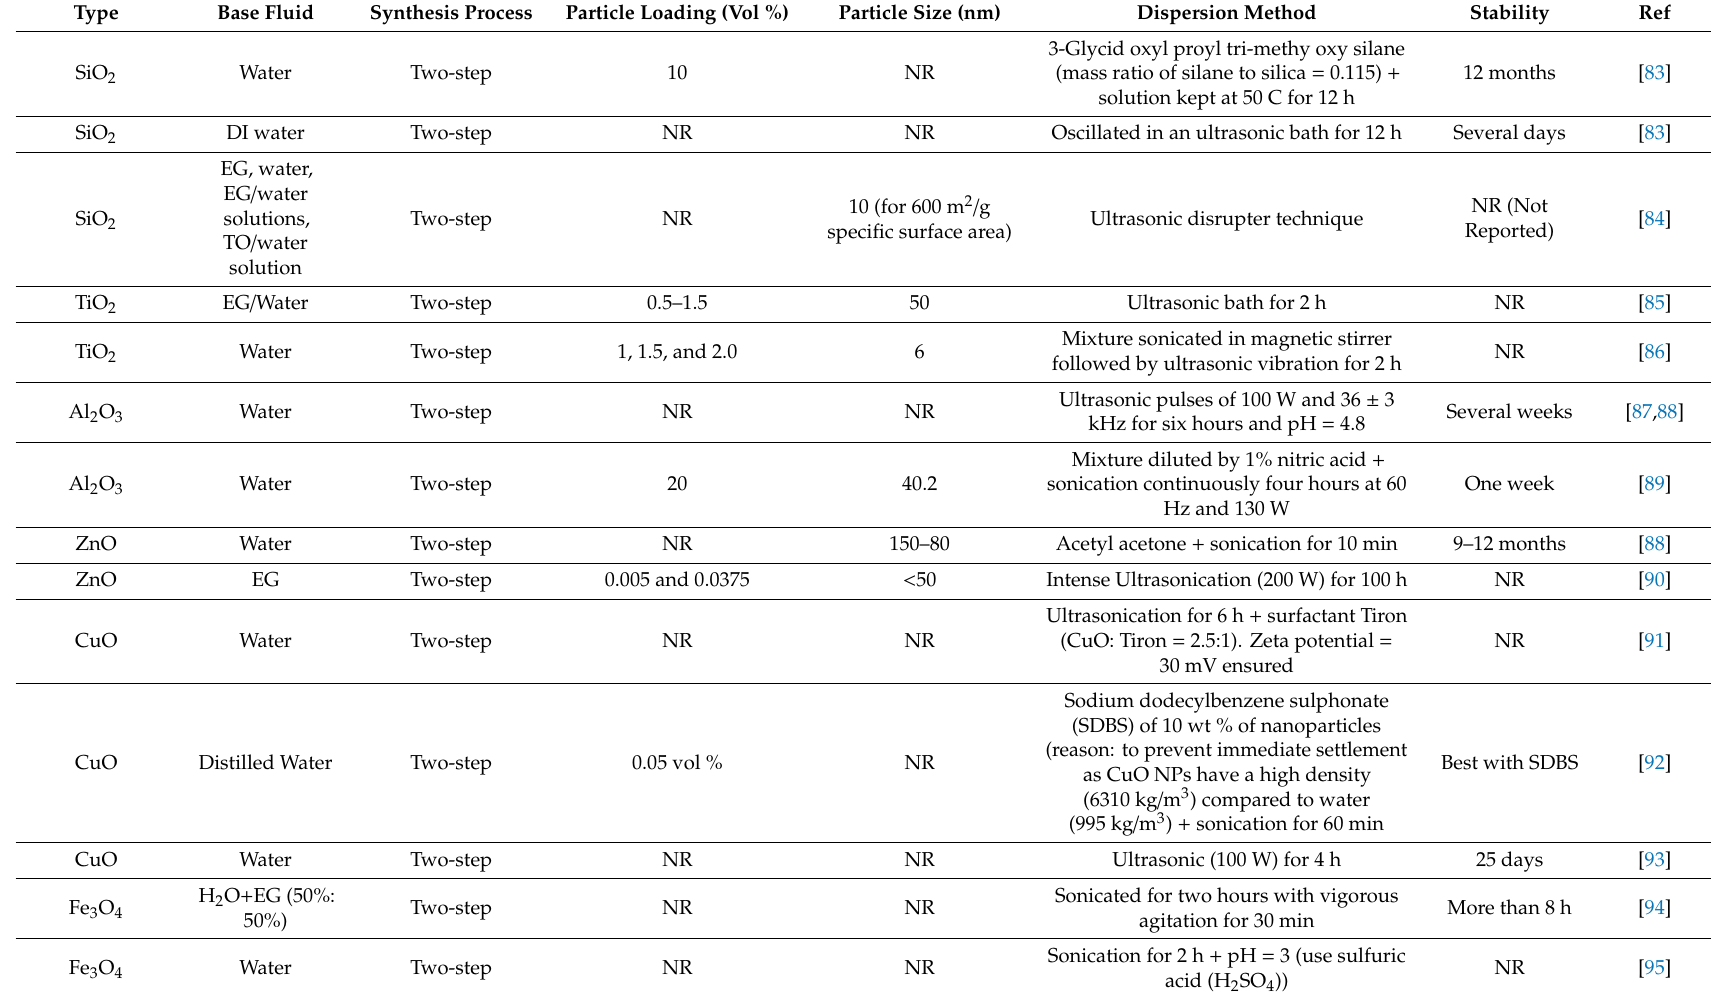
Table 7. Summary of the Nanofluids stability for various nanoparticles types, size, loading concentrations and dispersion methods